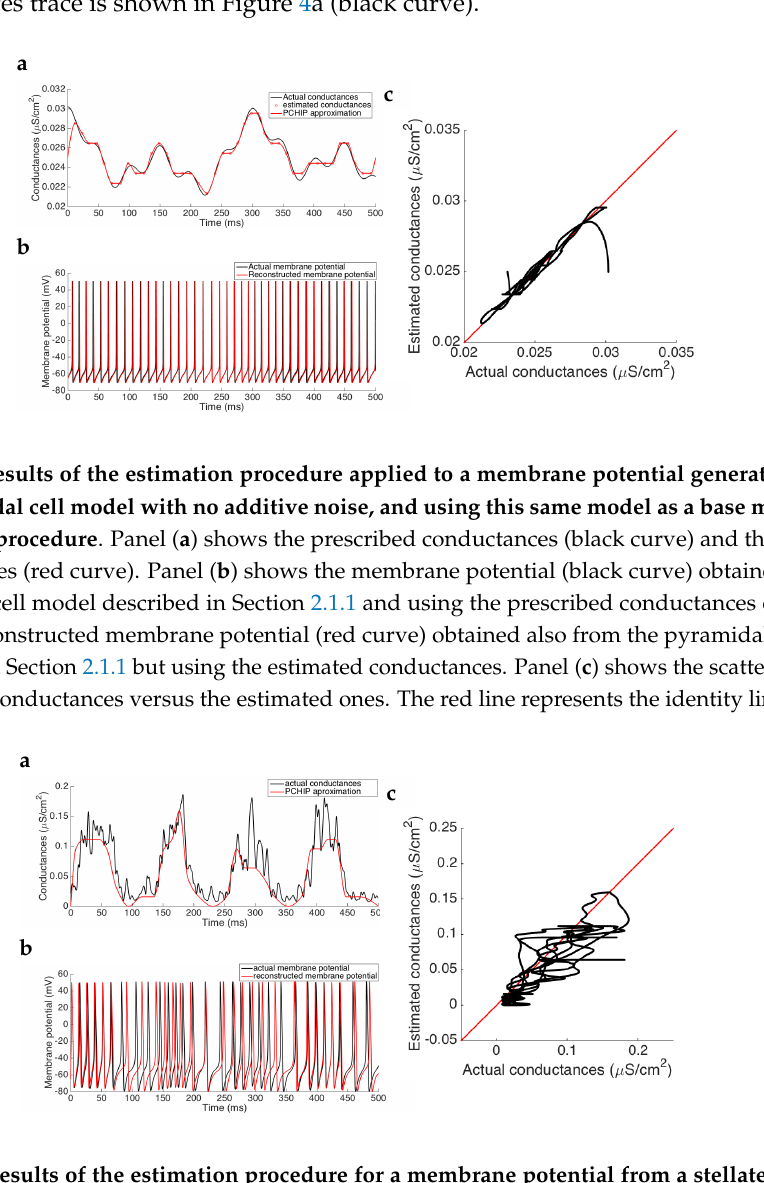
Figure 4. Results of the estimation procedure for a membrane potential from a stellate cell model using the same model as a base model in the estimation procedure. Panel ( a ) shows the prescribed conductances (black curve) and the estimated conductances (red curve). Panel ( b ) shows the membrane potential (black curve), obtained from the stellate cell model described in (4) when the prescribed conductances of Panel ( a ) has been used, while the red curve depicts for the reconstructed membrane potential, obtained also from the stellate cell model but using the estimated conductances. Panel ( c ) shows the scatter plot of the prescribed conductances versus the estimated ones. The red line represents the identity